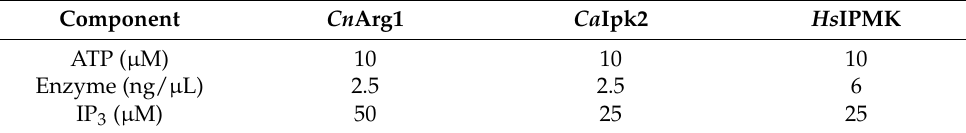
Table 2. Optimized concentrations of IP 3 and enzyme used in the inhibition assay.